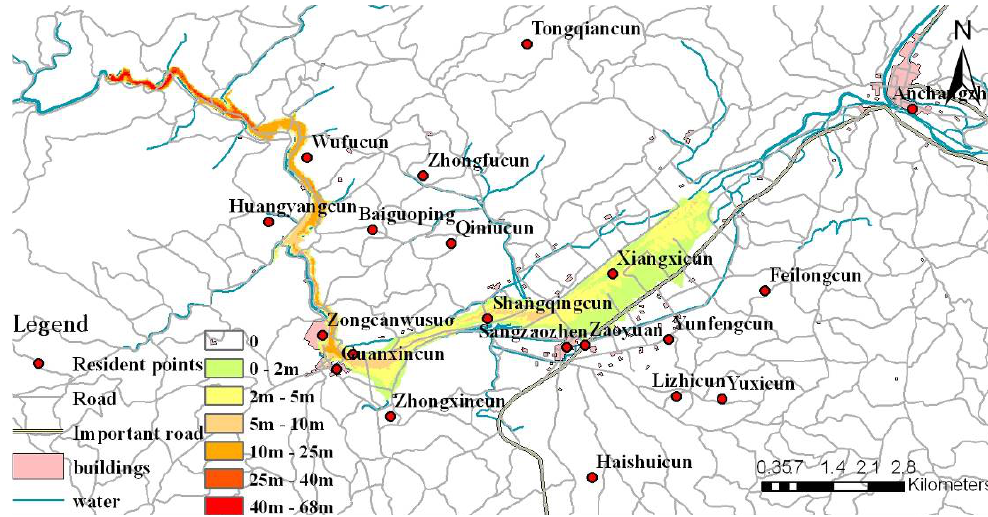
Fig. 9. Flood inundation potential analysis (5.19 full break).